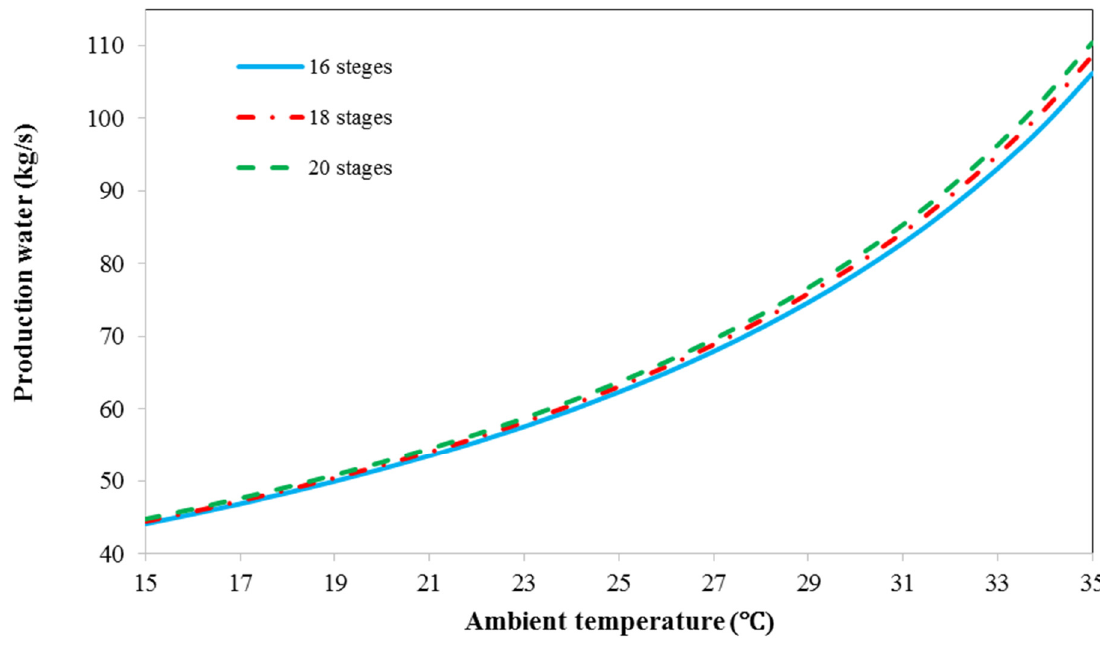
Figure 6. Variations of distillate water in terms of ambient temperature for the different number of stages .